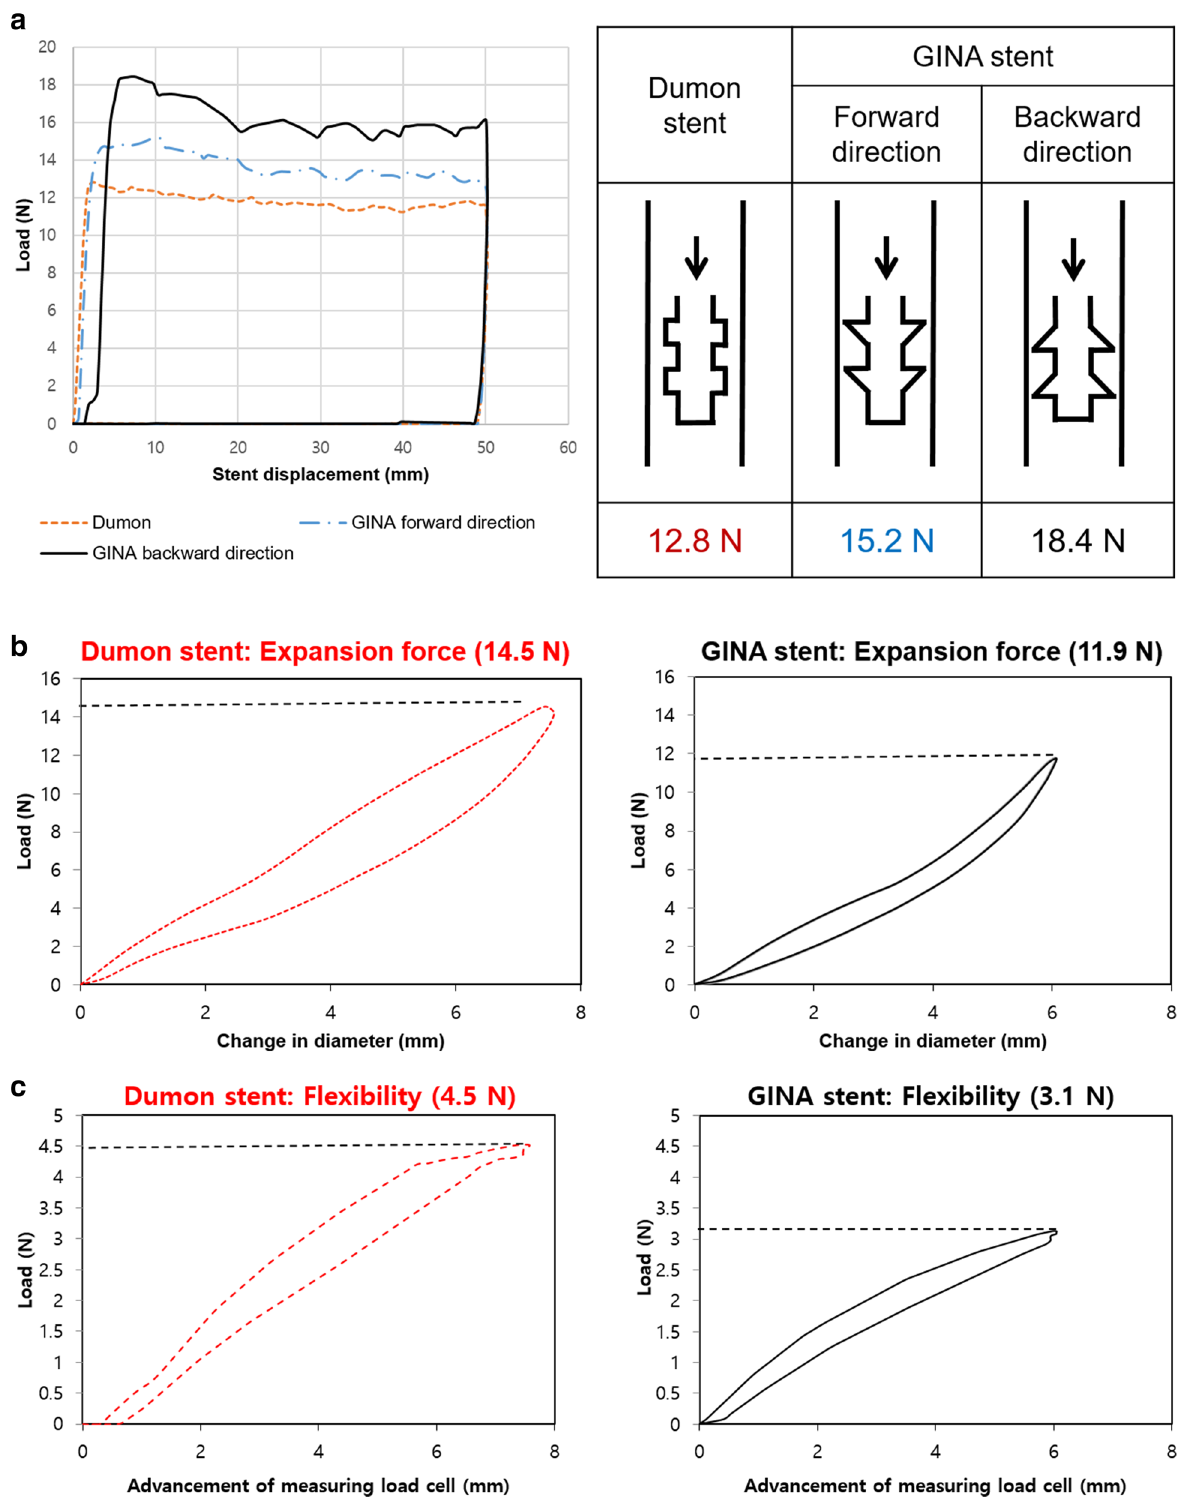
Figure 1. The results pertaining to the mechanical tests. ( a ) The GINA stent displayed stronger anti-migration force in both directions, compared to the Dumon stent. ( b , c ) The GINA stent displayed lower expansion force and higher flexibility. N